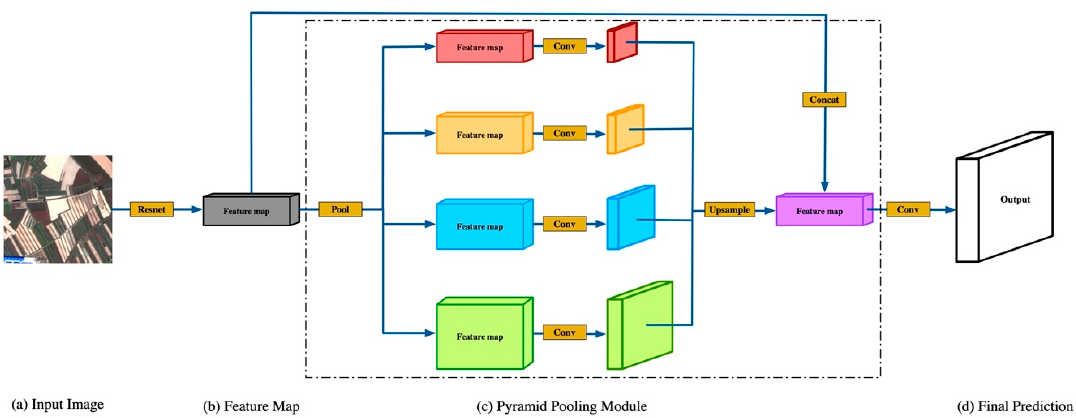
Figure 1. Overview of PSP-Net.